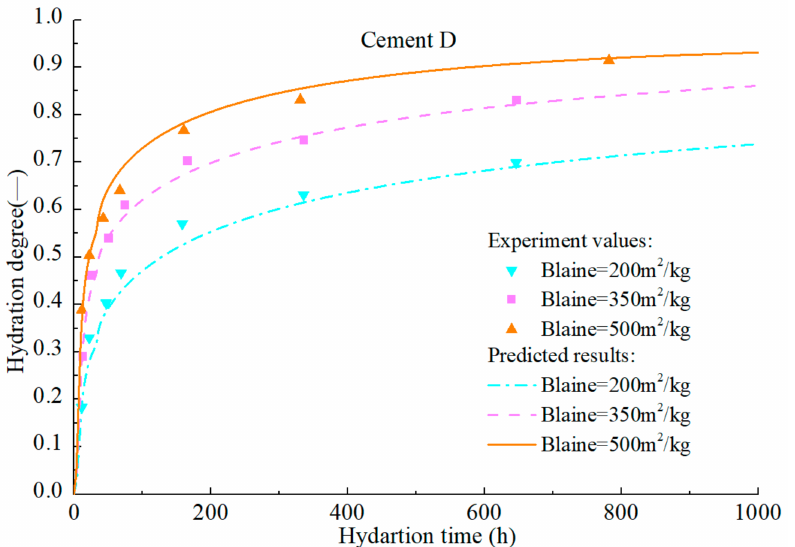
Figure 25. Measured and predicted hydration degree of cement D with different fineness.